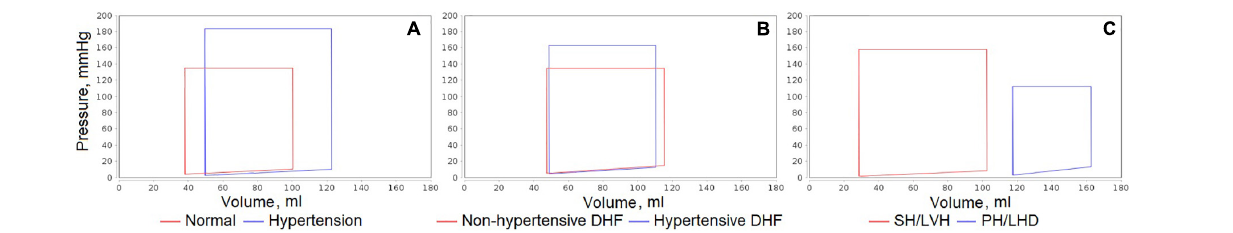
FIGURE 6 | Comparison of left ventricular pressure-volume loops simulated for different equilibrium states of the model. (A) Uncomplicated hypertension vs. normal state. (B) Non-hypertensive vs. hypertensive diastolic heart failure (DHF). (C) Pulmonary hypertension and left heart disease (PH/LHD) vs. systemic hypertension and left ventricular hypertrophy